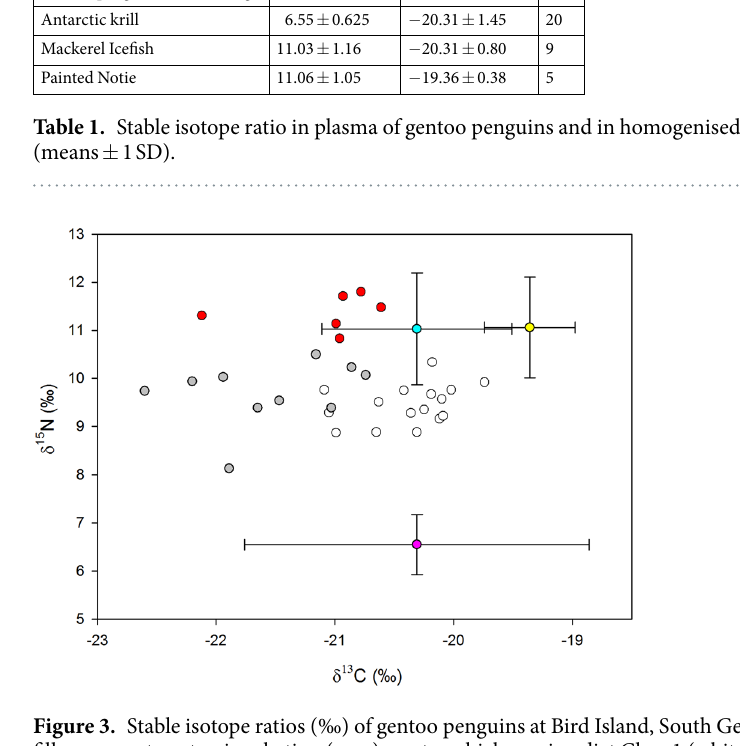
Figure 3. Stable isotope ratios (‰) of gentoo penguins at Bird Island, South Georgia, and their prey. Symbol fills represent gentoo incubation (gray), gentoo chick-rearing diet Class 1 (white), gentoo chick-rearing